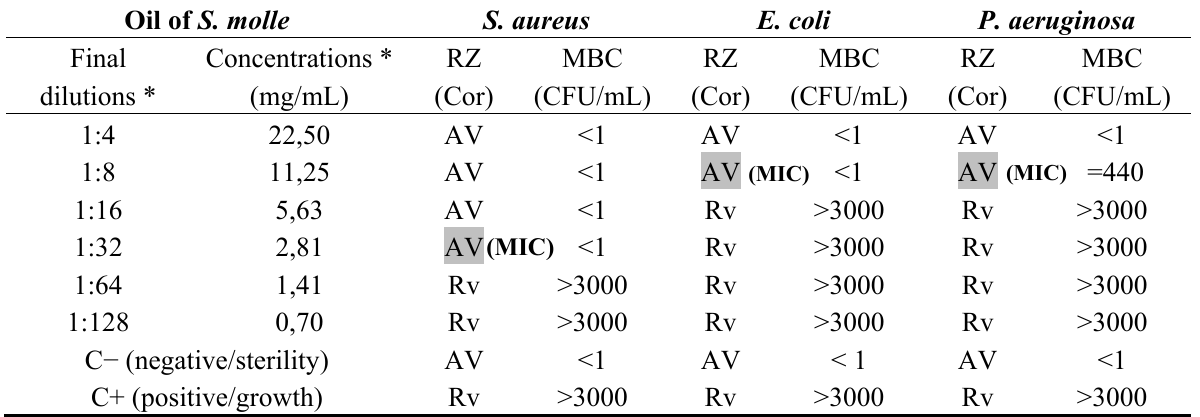
Table 8. Experimental CIM and CMB